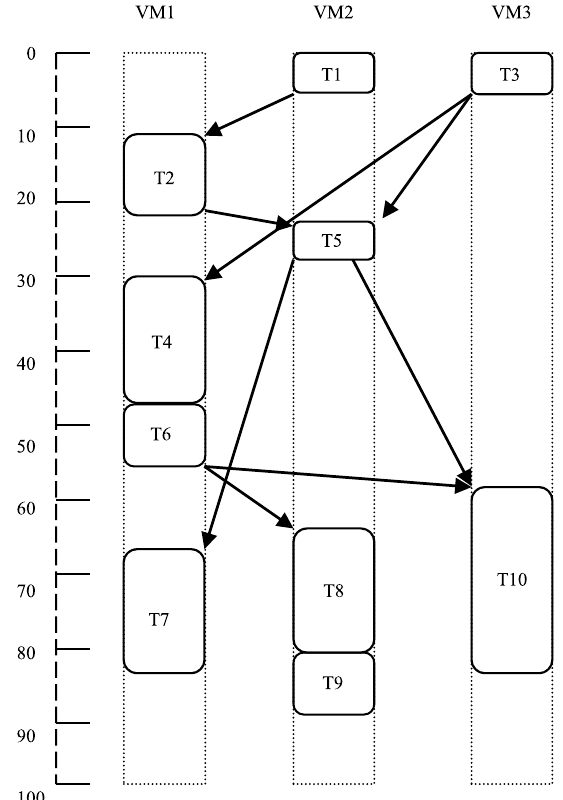
Fig.7 Scheduling of DAG with modified HEFT algorithm. (Use Of min schedule length idle slot in processor selection & Schedule length